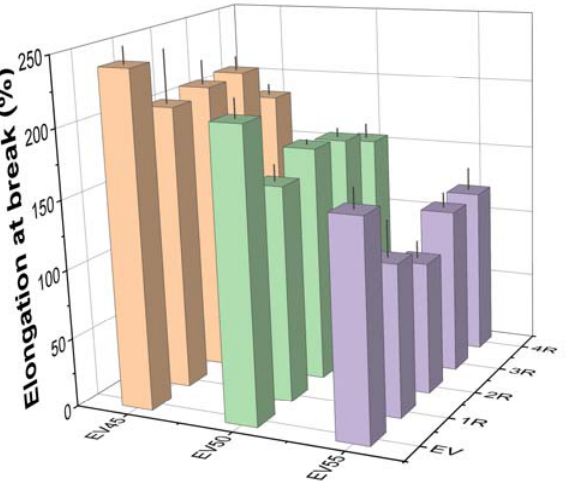
Figure 13. Elongation at break of the original and recycled epoxy vitrimers.